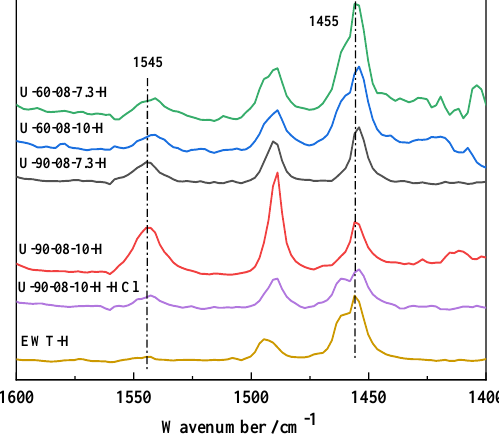
Figure 10. The Py-IR spectra of